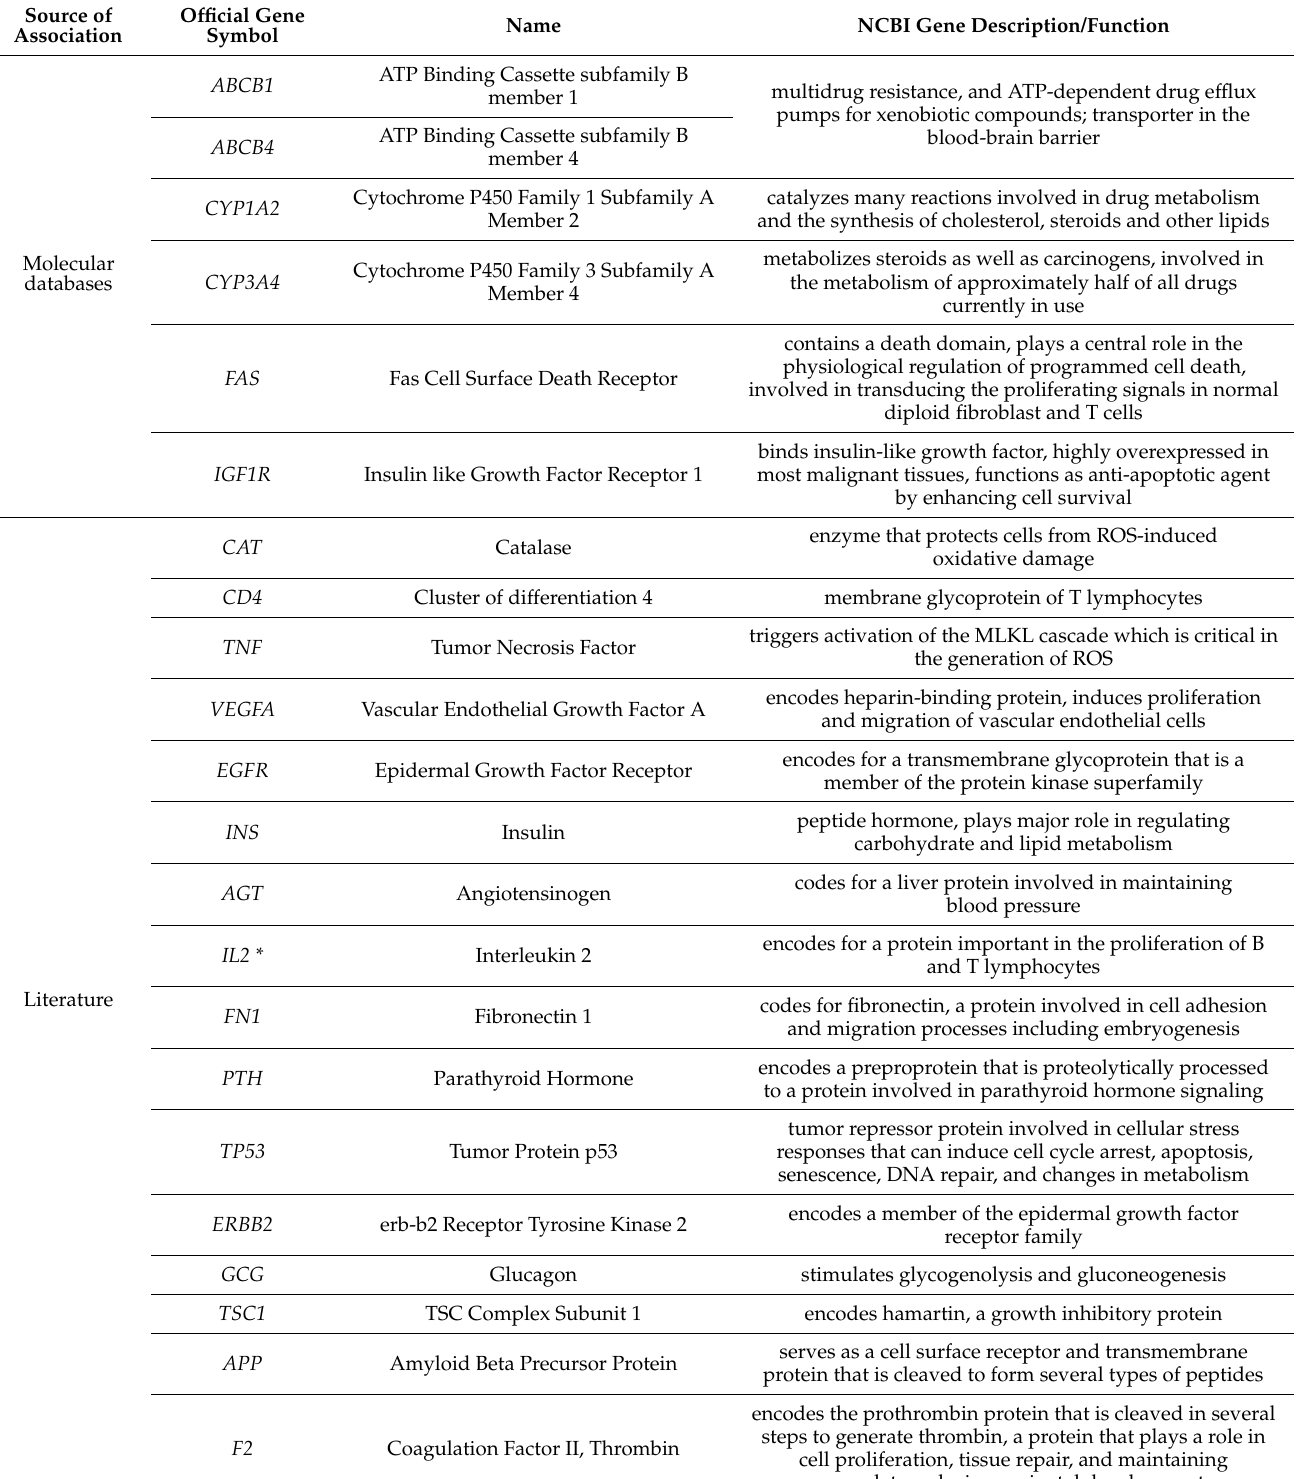
Table 4. Resulting genetic associations for the interaction between APAP, pesticides and